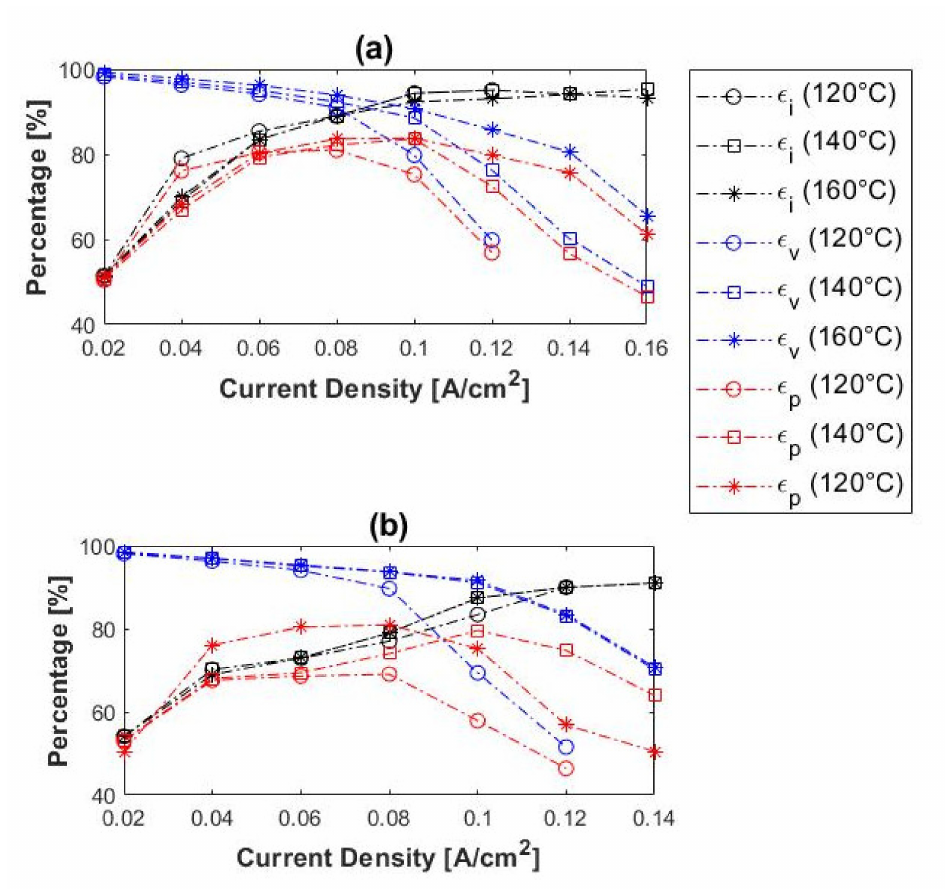
Figure 13. Current- ( ε i ), voltage- ( ε v ), and power ( ε p ) efficiencies as a function of current density at 120–160 ◦ C for ( a ) 10% and ( b ) 50% carbon dioxide, balance hydrogen (hydrogen flow rate = 100 mL n /min, 1